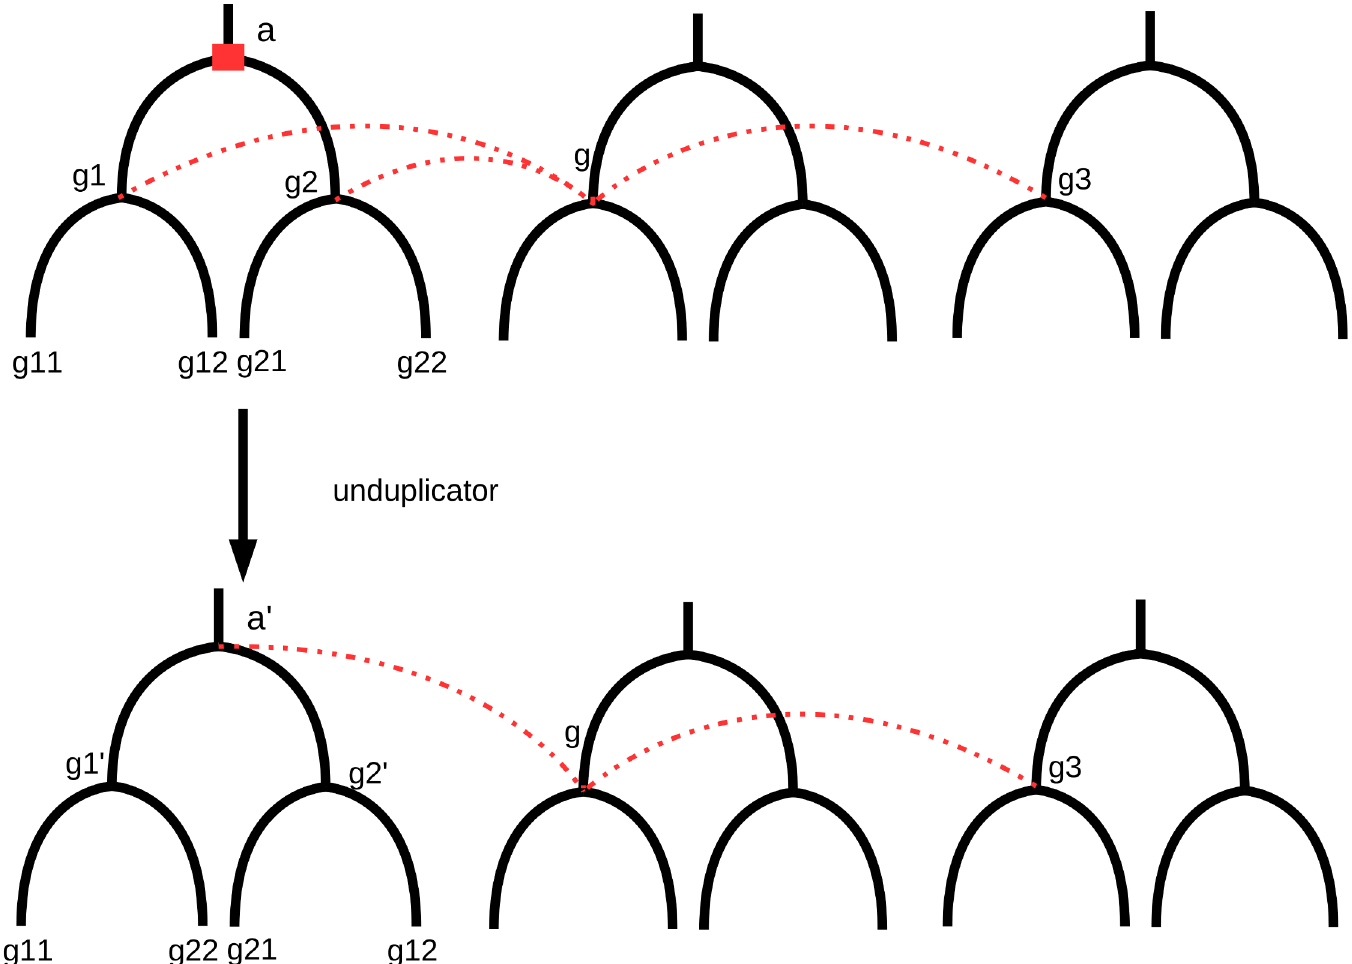
Fig 9. The unduplication principle (figure redrawn from [33]). A non linearity is detected in an ancestral genome (gene g has three neighbors). Two of its neighbors g 1 and g 2 are issued from a possibly dubious duplication labeled node. The tree is rearranged so that its root is labeled with a speciation instead of a duplication. In the resulting configuration g 0 1 and g 0 2 are in two different species, so that g can have only one neighbor in this family, and linearity is